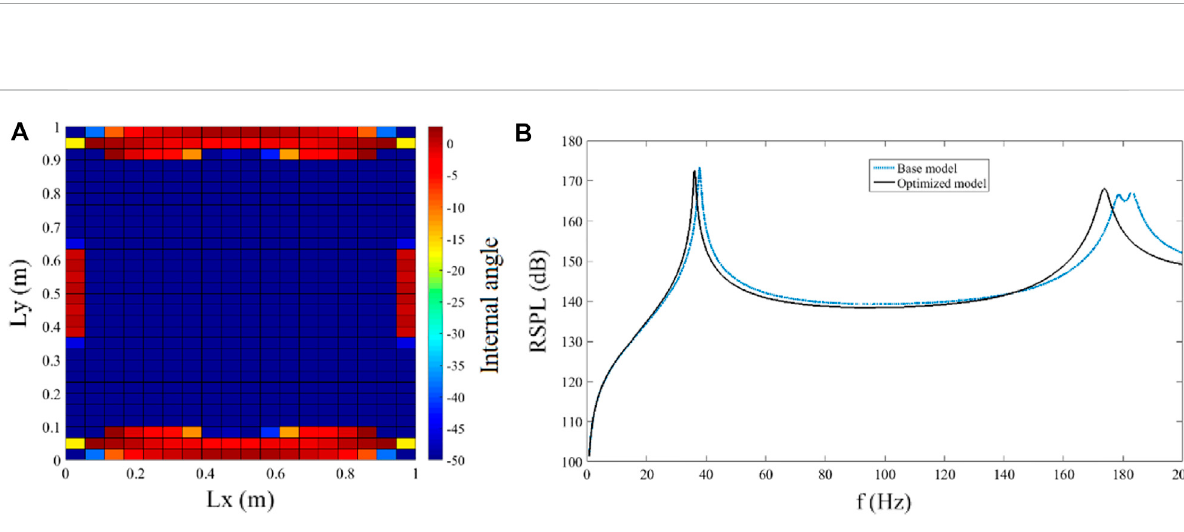
FIGURE 3 (A) Structure of the optimum core for the Violet noise excitation; (B) The RSPL of the optimized con fi guration in comparison with the base model. Reprinted from [21] with